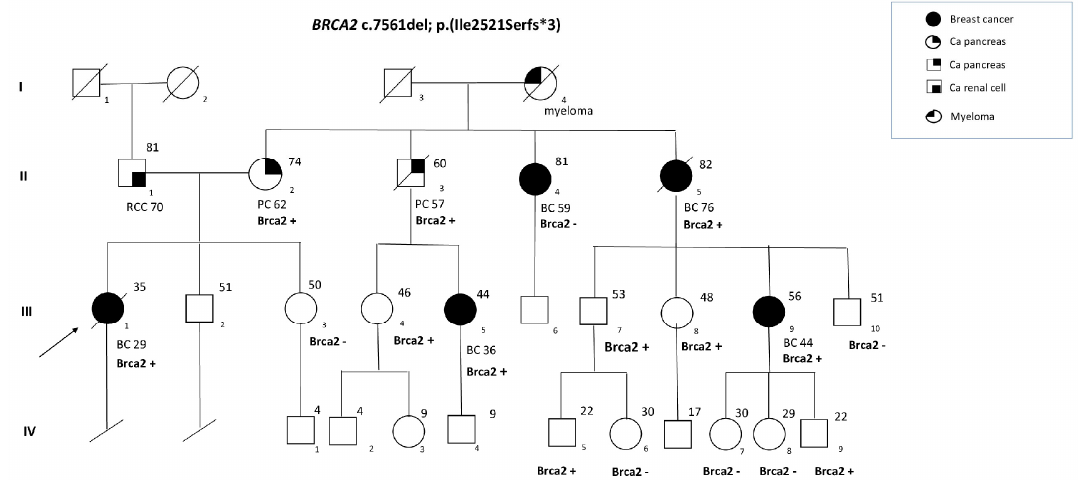
Figure 1. Representative pedigree of a family with BRCA2 c.7561del variant. I–IV represent generations. Circles represent females, squares represent males. Symbols that are fully dark represent breast-cancer patients. Symbols with a quarter represent subjects with other types of cancer. Symbols with a slash indicate deceased individuals. The arrow points to the proband. BC, breast cancer; PC, Pancreatic Cancer; RCC, Renal Cell Carcinoma; BRCA2 +, presence of PV in BRCA2; BRCA2 − , absence of PV in BRCA2. Table 1. BRCA2 germline pathogenic variant identified in patients and families. IARC, Interna ‐ tional Agency for Research of Cancer; dbSNP/ClinVar, variant classification according to the Single Nucleotide Polymorphism database (dbSNP) and Clinical Variant (ClinVar).